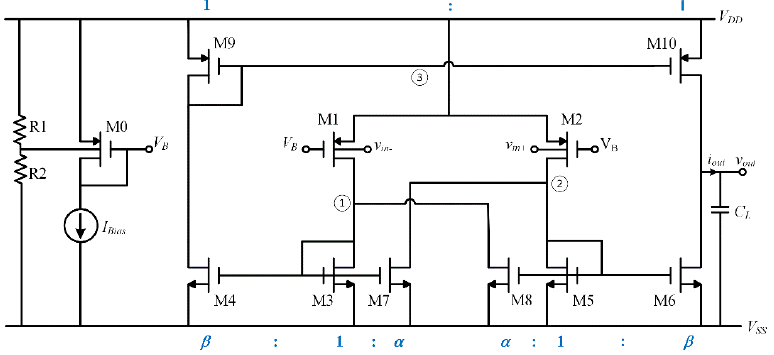
Figure 1. Proposed single-stage OTA.